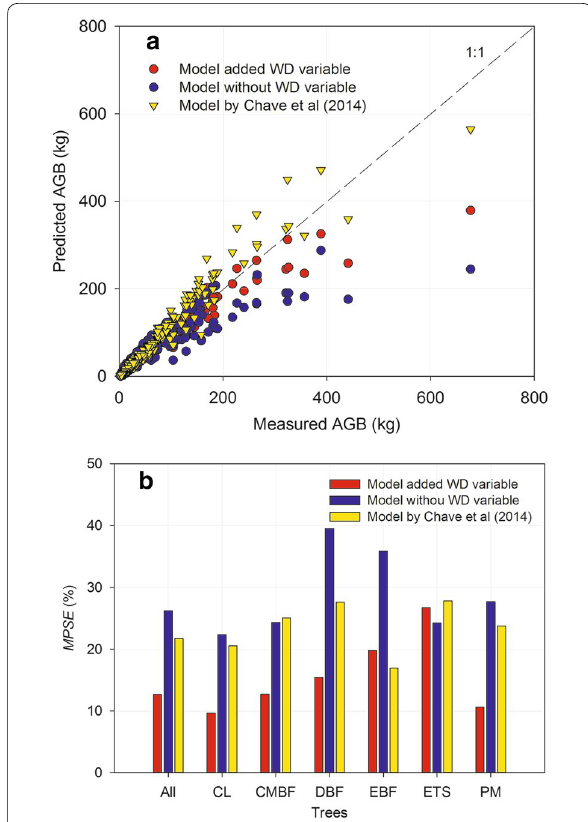
Fig. 4 Compared the measured AGB (aboveground tree biomass) and the estimated AGB in subtropical forests by the allometric model with wood density, the allometric model without wood density, and the model widely used in tropical trees created by Chave et al. (2014) 0.976 AGB est = 0.0673 × ρ D 2 H (cid:28) , respectively ( a ), and compared (cid:31) (cid:30) (cid:29) MPSE among these three allometric models ( b